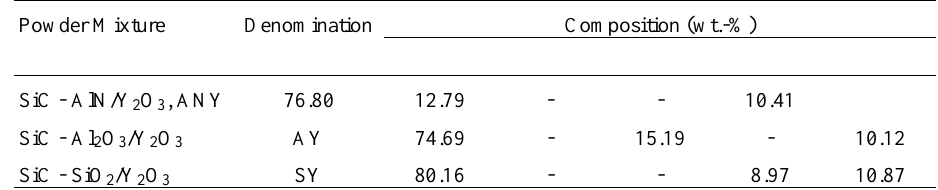
Table 1. Denomination and composition of the powder mixtures prepared.